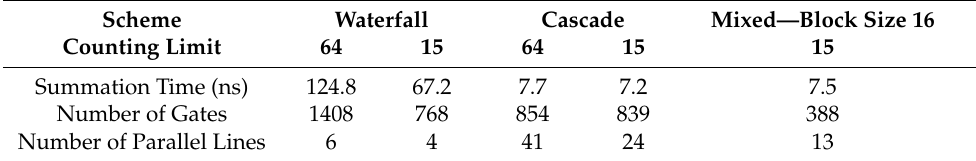
Table 3. Resources required for cascade, waterfall and mixed summation schemes.